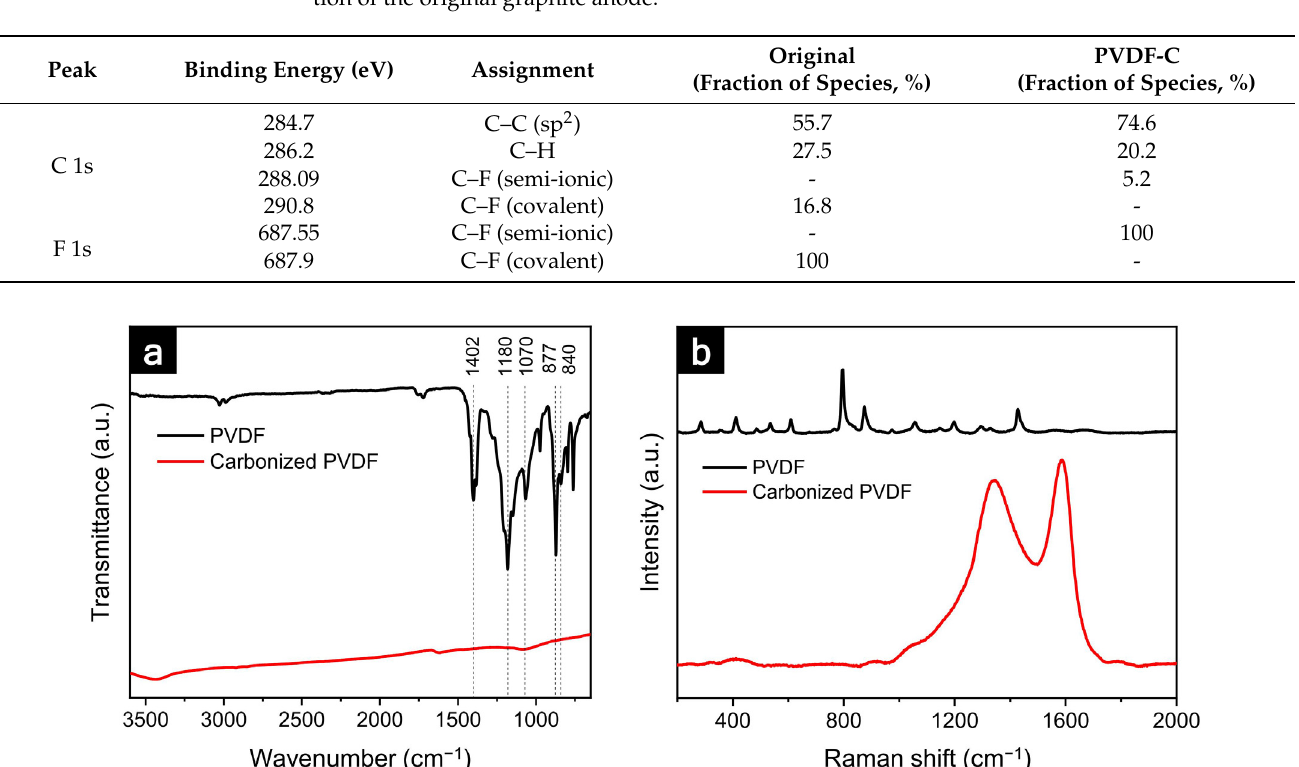
Figure 2. ( a ) FTIR spectra and ( b ) Raman spectra of pristine and heat-treated PVDF powders.